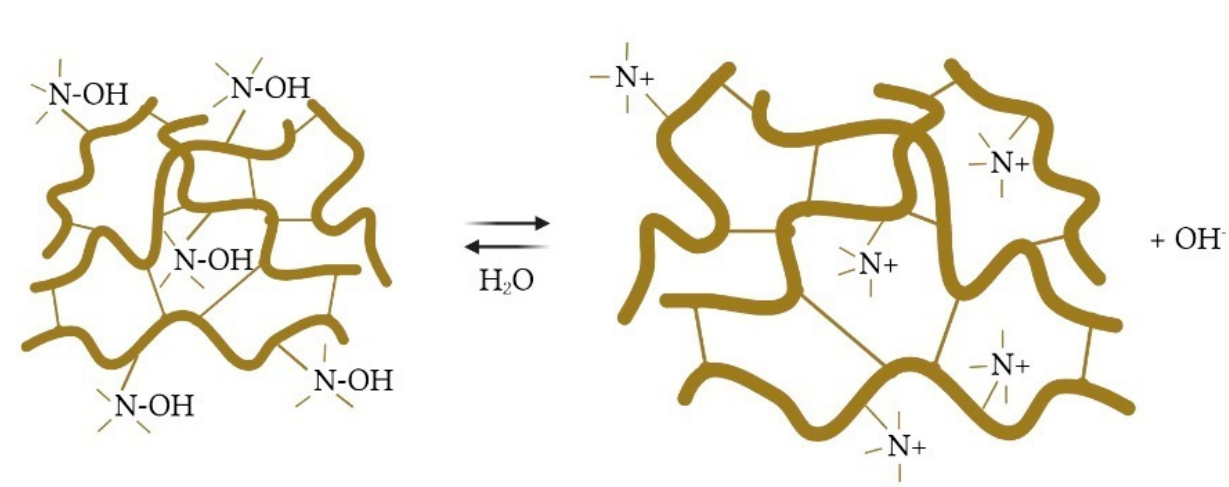
Figure 3. The dissociation of AV-17-8 ion exchanger in aqueous solution.